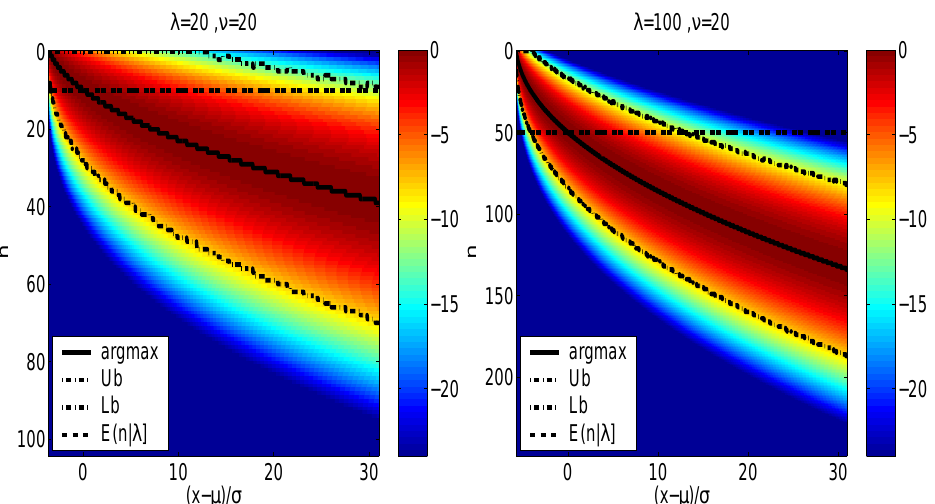
Figure 2. The magnitude of the normalized terms r ( x, n | λ , ν ) for ν = 20 . The peak is shown as a function of x for various non-centrality parameters λ . The difference between (cid:98) λ / 2 (cid:99) and the actual n ∗ = argmax r ( x, n | λ , ν ) in the tail regions is apparent. The upper n (Ub) and lower (Lb) bounds of Algorithm 3 for the interval of summation associated with B = 8 decimal place accuracy.